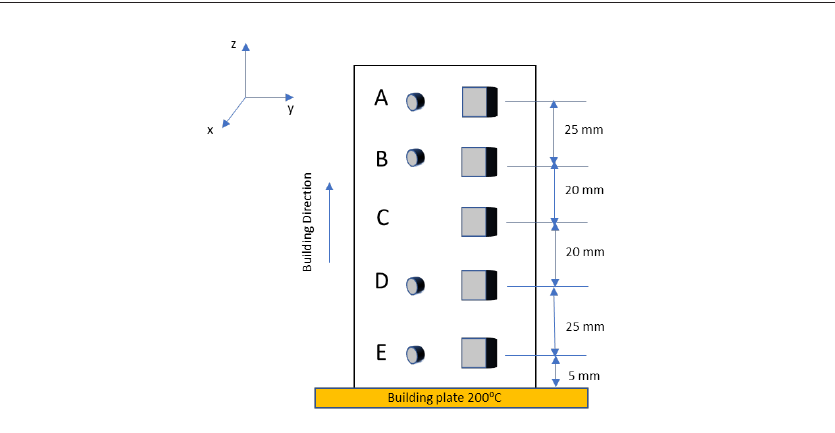
Fig. 1 Schematic of sample extraction from the SLM product.